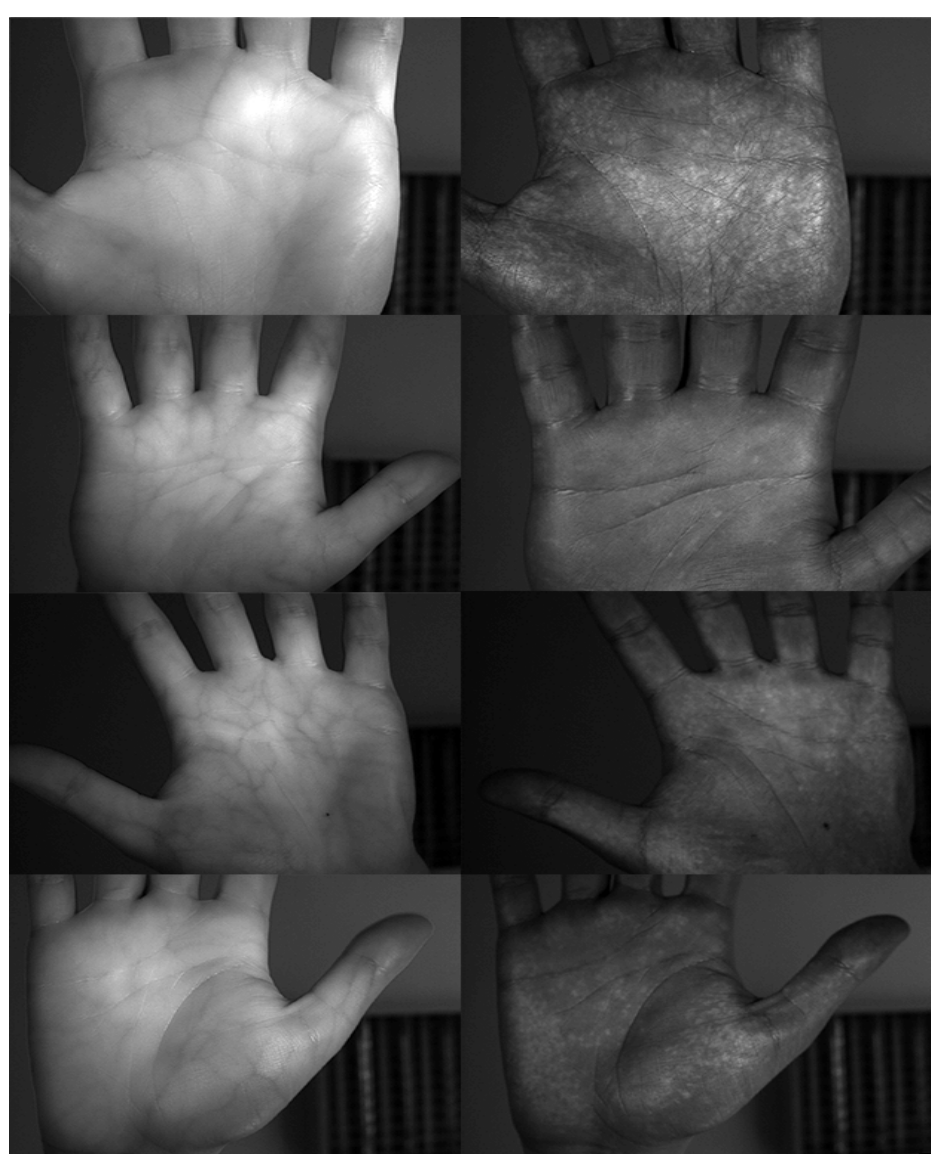
Figure 3. Example of images taken in IR ( left ) and UV ( right ) lighting from the